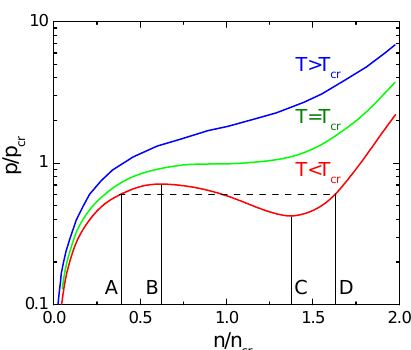
Figure 1. Schematic pressure isotherms as functions of the number density n at a liquid-gas-like phase transition. P cr , n cr , and T cr are the pressure, density, and temperature at the critical point. Adiabatic trajectories ˜ s cr and ˜ s m , where ˜ s const, and s is the entropy density, are shown in s / n ≡ (cid:39) Figure 2 on the plot of T / T cr = f ( n / n cr ) by the short dashed lines. The upper convex curve, MC, the bold solid line, demonstrates the boundary of the MC, the bold dashed line, ITS, shows the boundary of the isothermal spinodal region, and the bold dash-dotted curve, AS, indicates the boundary of the = ( ∂ P / ∂ρ ) = 0; at the AS line, u 2 = ( ∂ P / ∂ρ ) ˜ = 0, adiabatic spinodal region. At the ITS line, u 2 s T ˜ s T where u T and u ˜ s have the meaning of the isothermal and adiabatic sound velocities, respectively, ρ = m ∗ n , and m ∗ is the baryon quasiparticle mass. The supercooled vapor (SV) and the overheated liquid (OL) regions are situated between the MC and the ITS curves, on the left and on the right, respectively. For ˜ s cr > ˜ s > ˜ s MC2 , where ˜ s cr is the value of the specific entropy ˜ s at the critical point and the line with ˜ s MC2 in the example shown in Figure 2 passes through the point n / n cr = 3 at T = 0, the system traverses the OL state (the region OL in Figure 2), the ITS region (below the ITS line), and the AS region (below the AS line). For ˜ s > ˜ s cr , the system trajectory passes through the SV state (the region SV in Figure 2) and the ITS region.